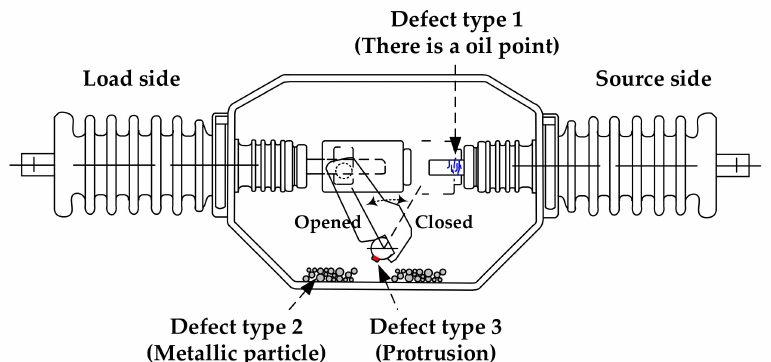
Figure 2. Diagram of the internal defects of the switch.